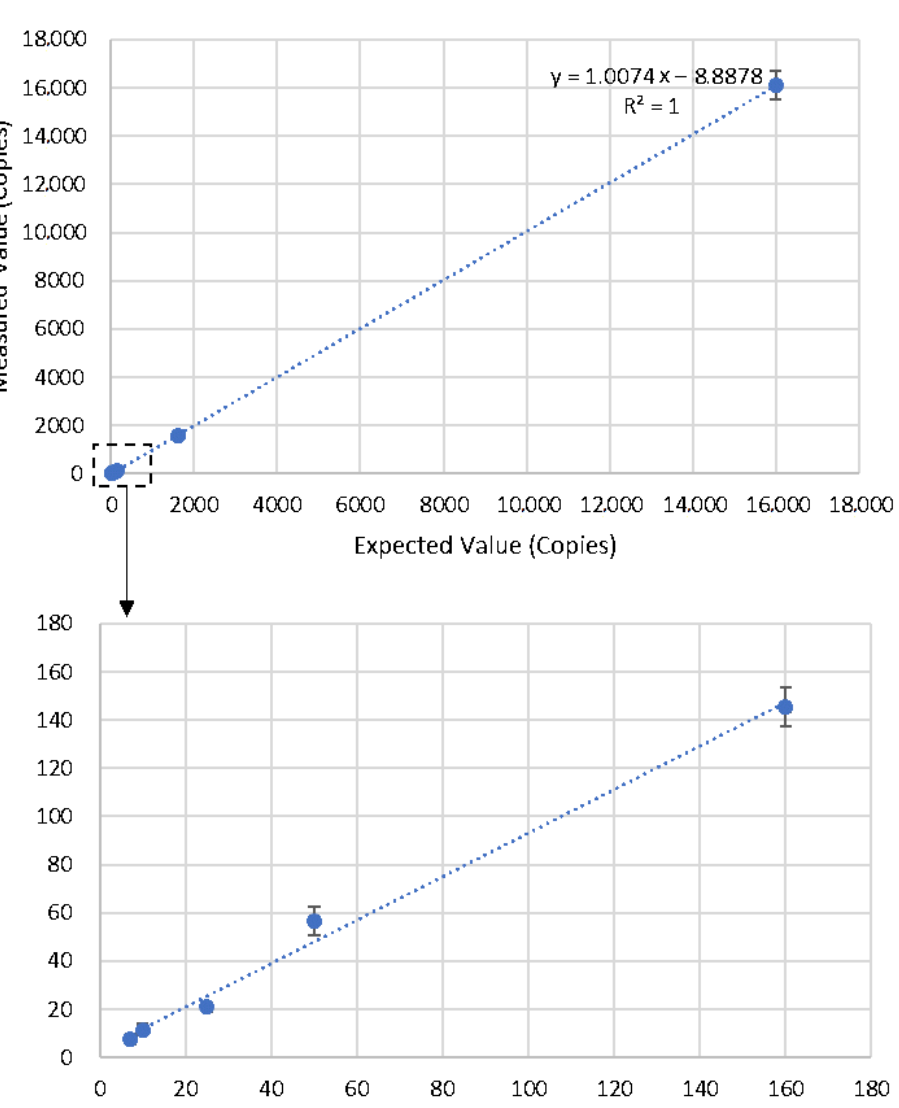
Figure 3. Dynamic range of KoP1 event-specific ddPCR assay.